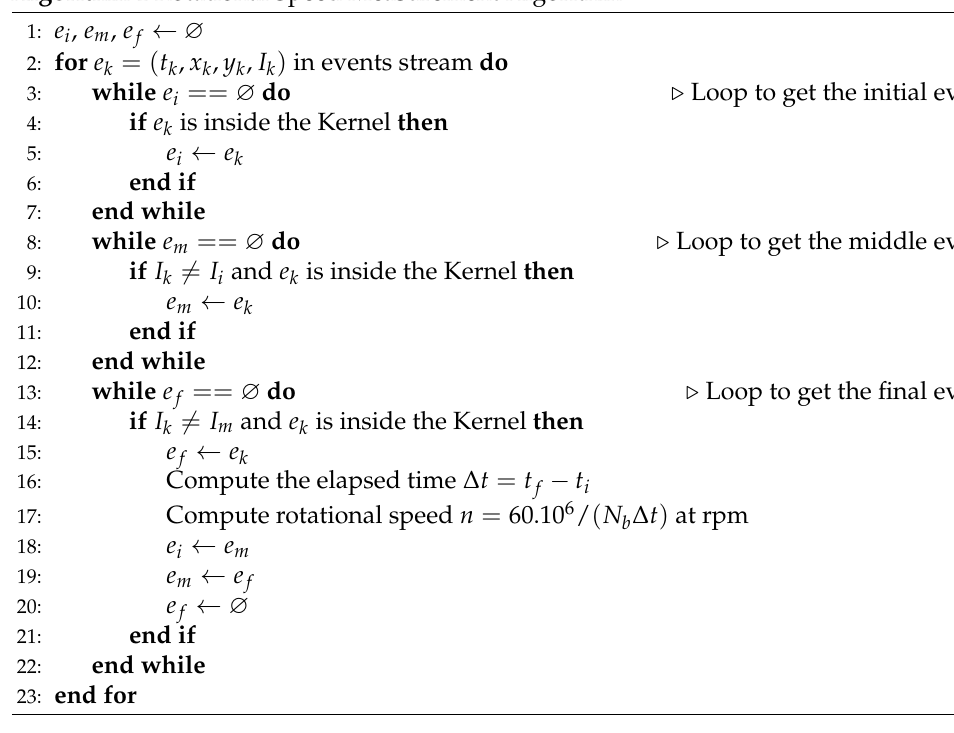
Algorithm 1 Rotational Speed Measurement